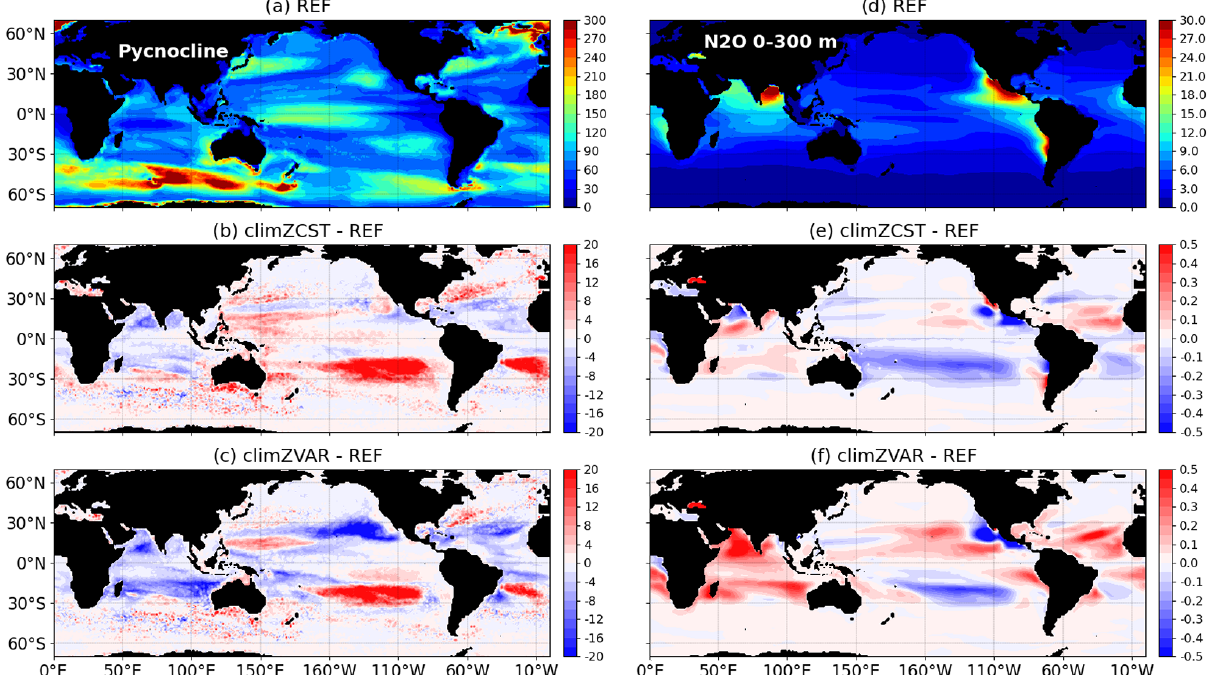
Figure 5. (a–c) Depth of annual pycnocline (m) for 2009–2018 computed as the annual mean depth of the maximum of the Brunt–Väisälä frequency N 2 (T, S) over the water column (Maes and O’Kane, 2014). (d–f) Mean [N 2 O] (µmolNm − 3 ) over the first 300m depth. For REF (a, d) and its mean-state differences in relation to climZCST (b, e) and climZVAR (c, f) .